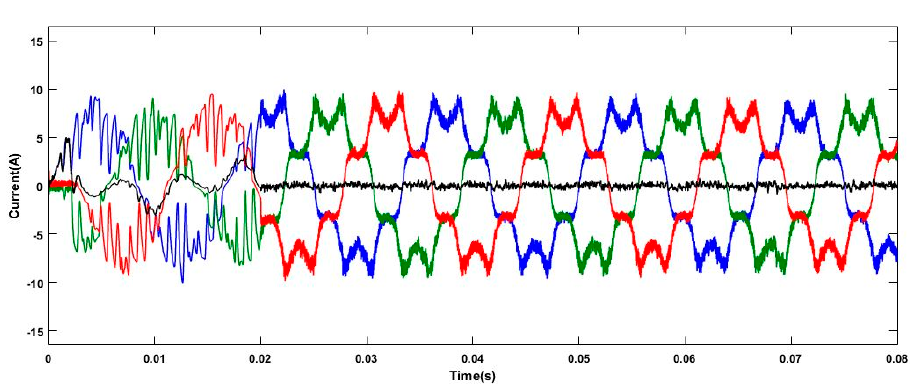
Figure 14. Source current without SAPF compensation for case 3.